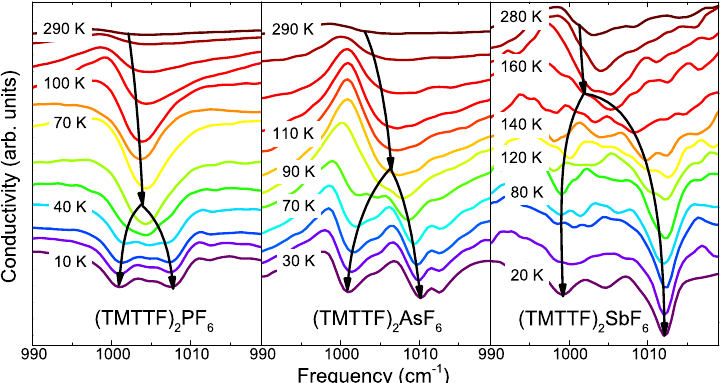
( ν ) of (TMTTF) PF and (TMTTF) AsF for light 1 2 6 2 6 ( a ) mode for temperatures above and below T . The curves 3 g CO SbF the spectra were too noisy to identify any 2 6